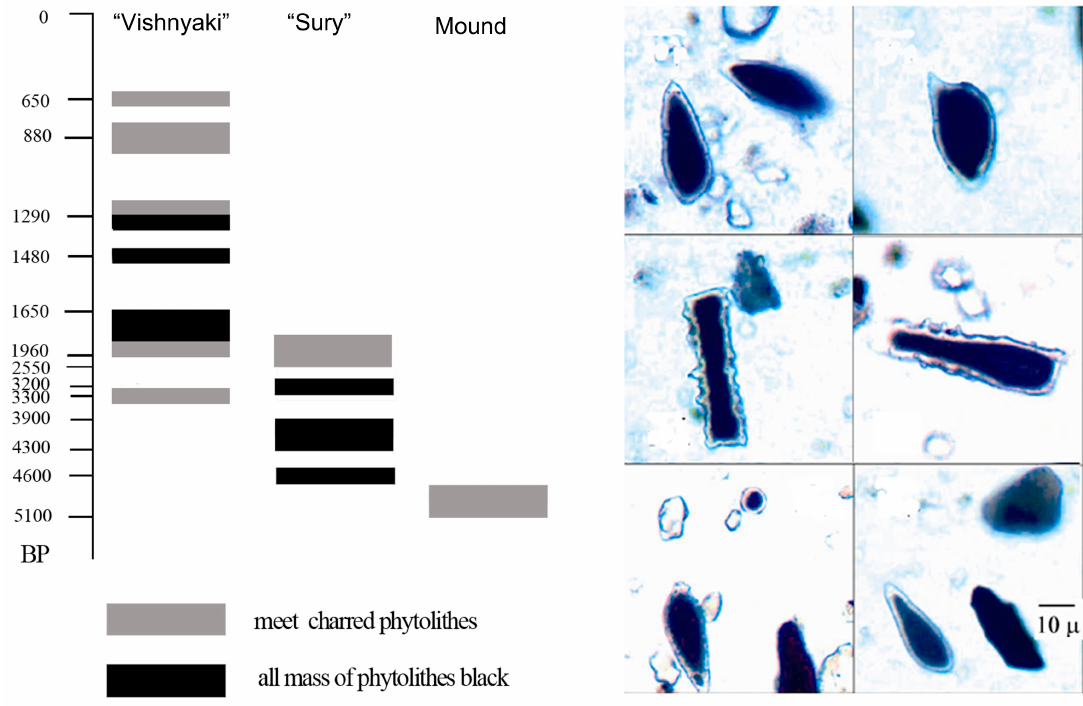
Figure 9. History of the steppe fires in the Yamskaya steppe site as recorded in phytolithes from soils and colluvial fan deposits.